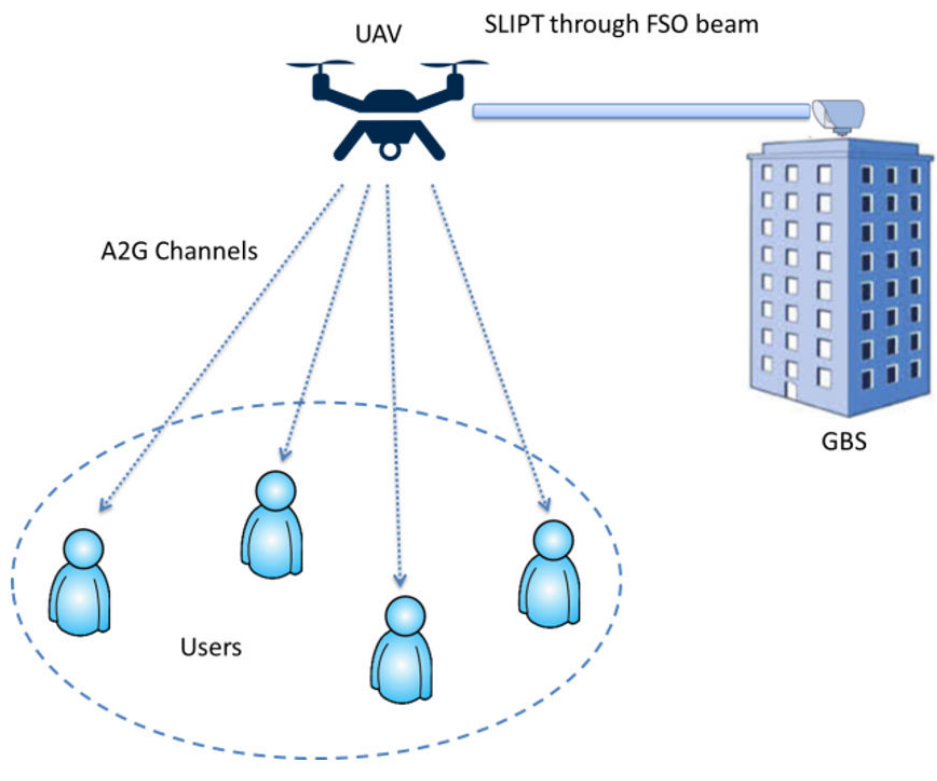
Figure 16. An illustration of A-RAN with SLIPT. In Table 5 different charging techniques for UAVs are shown. Table 5. A comparison of different UAV charging techniques in various